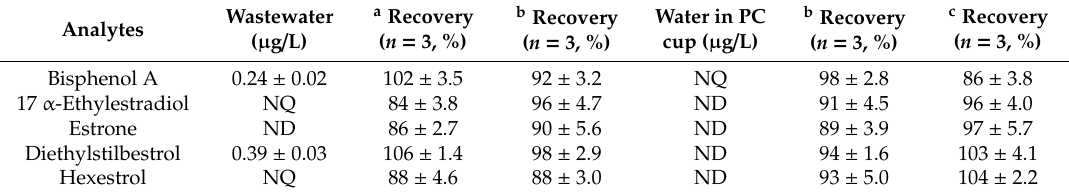
Figure 6. HPLC chromatograms of real water samples including ( A ) wastewater sample, spiked at 2 and 5 µ g / L, and ( B ) water sample in polycarbonate (PC) cup, spiked at 5 and 10 µ g / L. Peaks: (1) bisphenol A, (2) 17 α -ethylestradiol, (3) estrone, (4) diethylstilbestrol and (5) hexestrol. Conditions: sampling volume, 60 mL; sampling rate, 1.50 mL / min; methanol content in sample, 1.0% ( v / v ); desorption time, Table 2. Analytical results and the recovery of five estrogens in two real